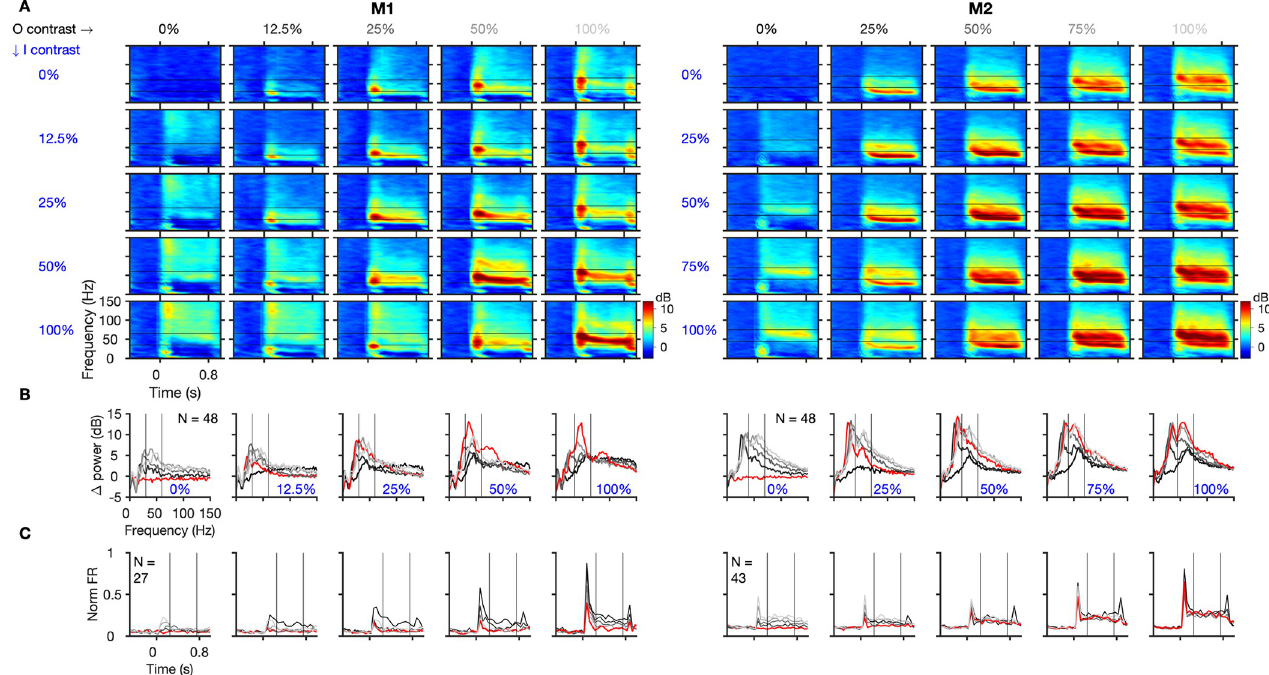
Fig 5. Gamma oscillations are reduced by contrast discontinuity. (A) Trial-averaged TF difference spectra for the population, induced by stimuli with contrast discontinuity (inner and outer contrasts are indicated on the left and top, respectively) and (B) the corresponding mean change in power from baseline to stimulus period. (C) Mean normalized firing rate averaged across selected spiking center electrodes and sessions. Same format as Fig 3A–3C. In B–C, every column shows graphs for varying outer contrast (increasing with brightness of gray), at a fixed inner contrast (mentioned in (B), and the colored red line represents the stimulus with the corresponding matched inner-outer contrast). Figure data are located at https://doi.org/10.5281/zenodo.6523772. M1, Monkey 1; M2, Monkey 2; TF, time frequency.